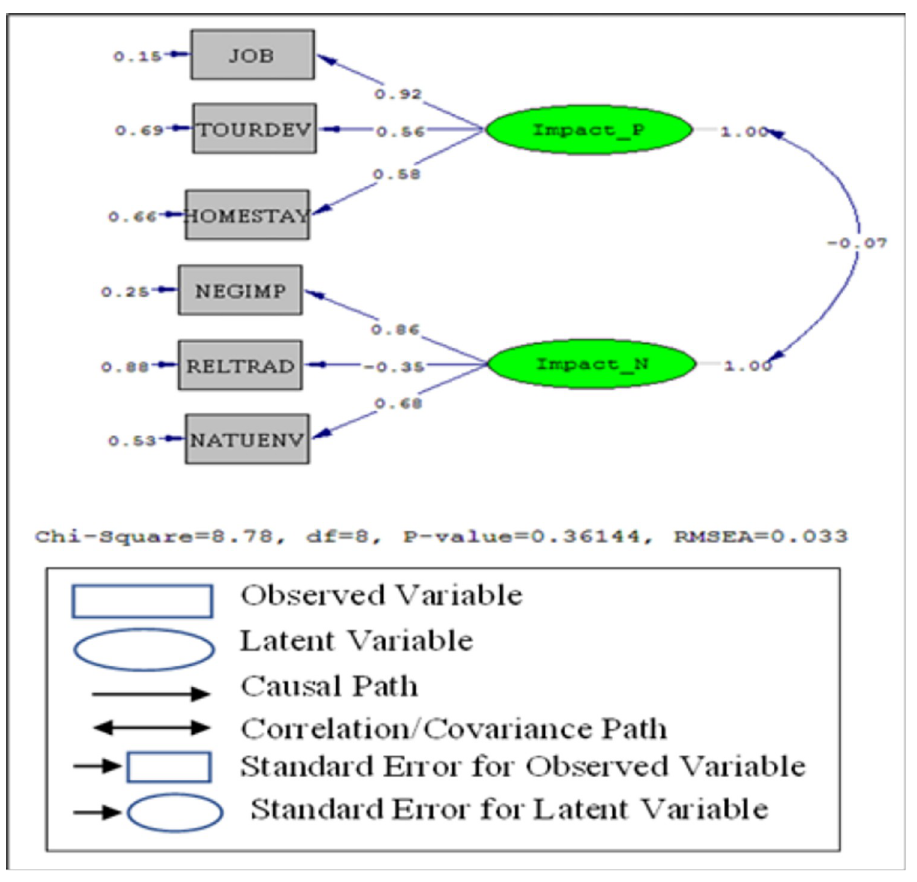
Fig 1. Structural equation model parameters for the impacts of ecotourism development (LISREL outputs).